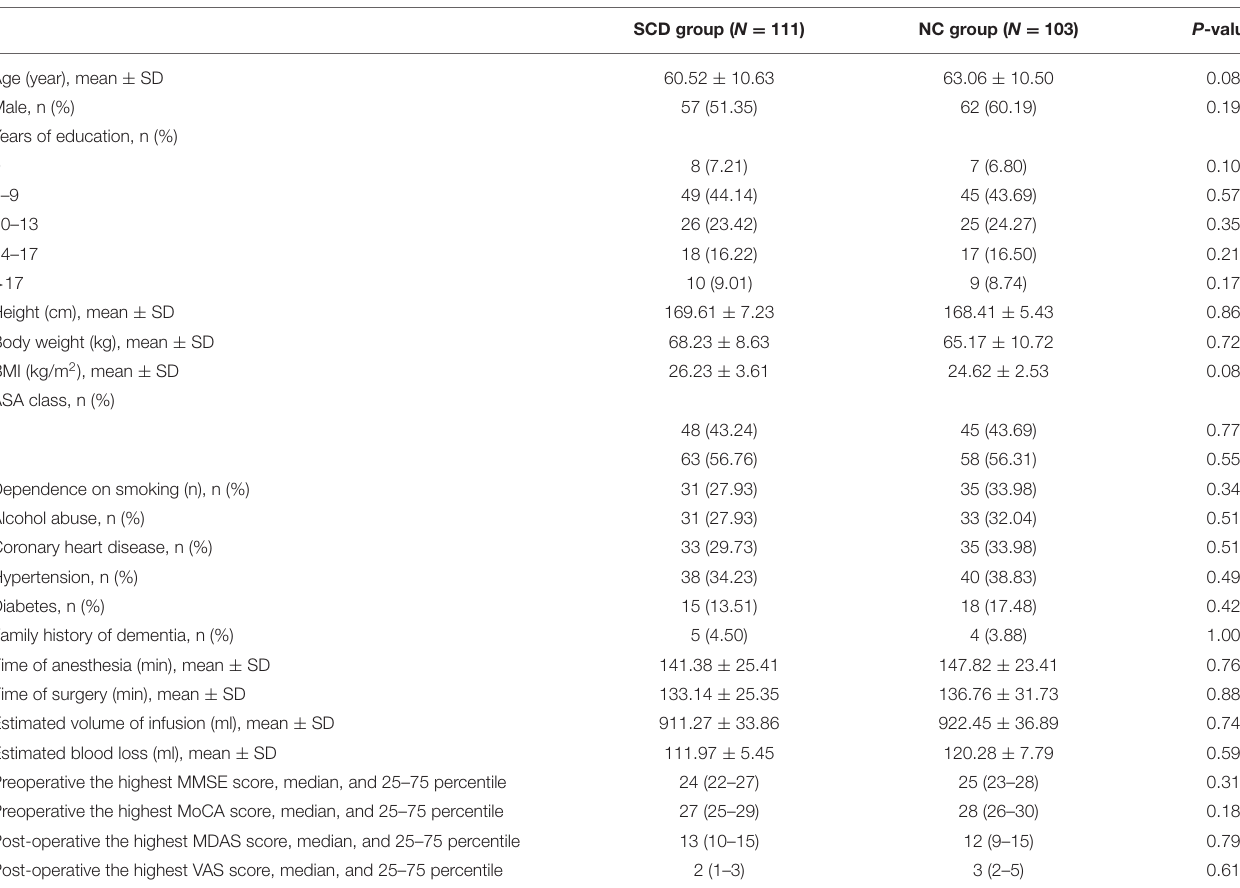
TABLE 1 | Characteristics of participants.